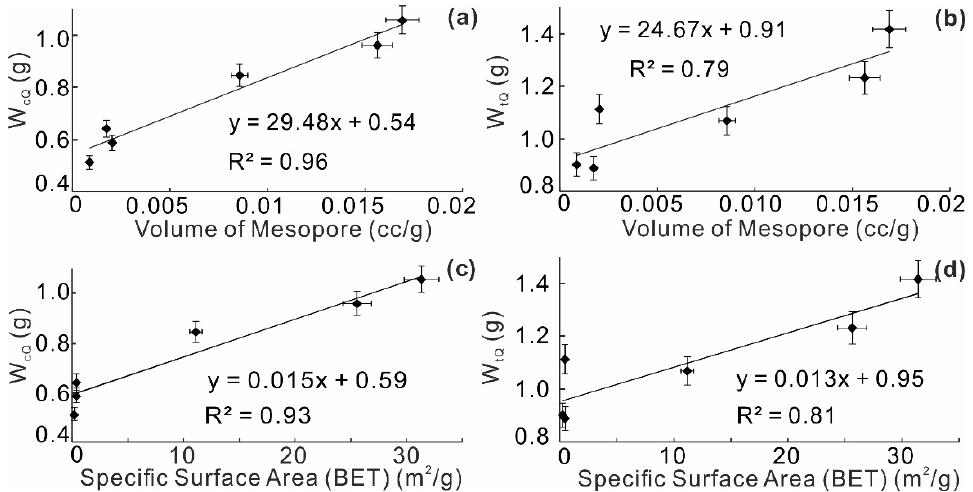
Figure 11. Cross-plots of the mesopore volume versus ( a ) weight of clay-sized quartz (W cQ ); ( b ) weight of total quartz in bulk shale (W tQ ). Cross-plots of the specific surface area (BET) versus ( c ) weight of clay-sized quartz (W cQ ); ( d ) weight of total quartz in bulk shale (W tQ ). Pore data from [48]. Error bars show a 5 % variation in each data point.